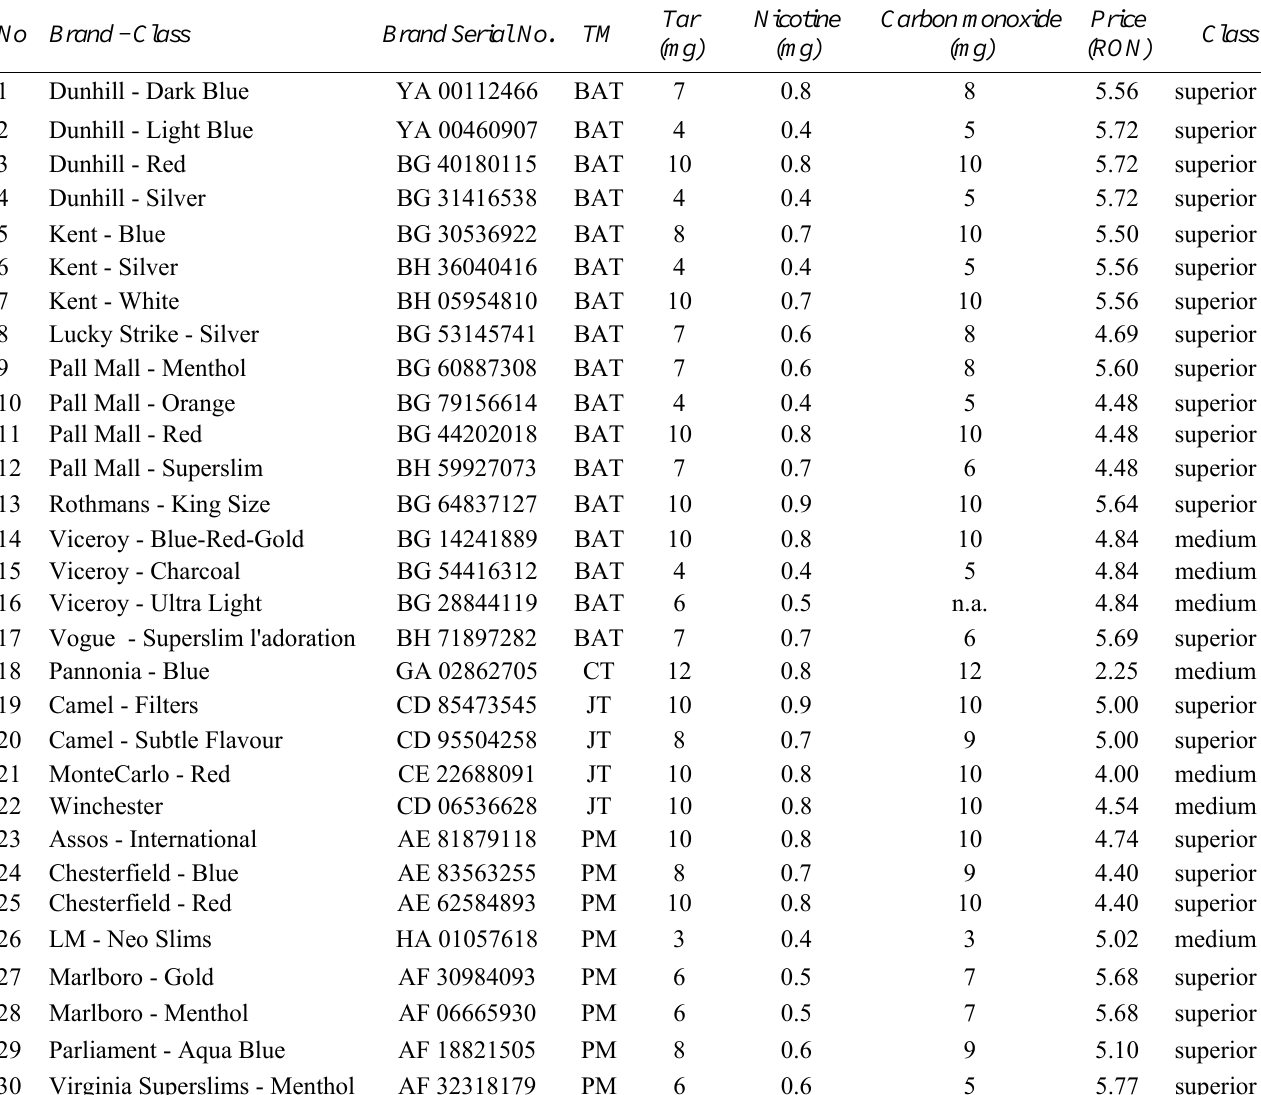
Table 1: Sample of investigated cigarettes No Brand - Class